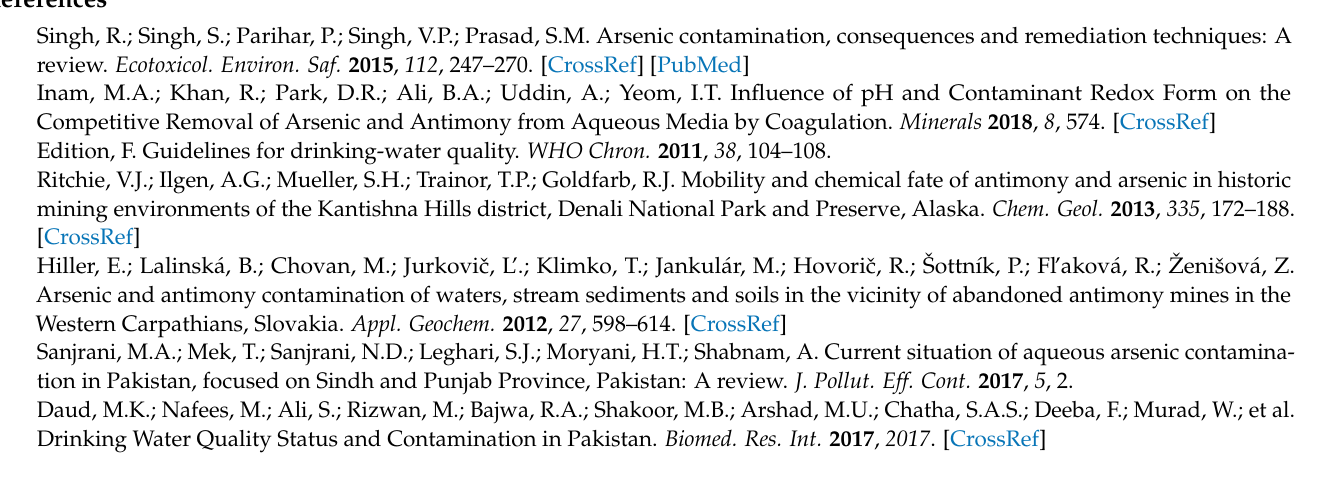
Figure S2: FHO formation in the presence of 1000 µ g/L (A) As (III) and (B) As (V) species, neutral pH, 0.1 m mol/L FC dosage and various temperature (15–35 ◦ C) and contact times (0–28 min), Figure S3: FHO formation in the presence of 100 µ g/L (A) As (III); and (B) As (V) species at optimum pH and temperature under various FC dosages in water, Figure S4: FHO formation in the presence of 500 µ g/L (A) As (III); and (B) As (V) species at optimum pH and temperature under various FC dosages in water, Figure S5: FHO formation in the presence of 1000 µ g/L (A) As (III); and (B) As (V) species at optimum pH and temperature under various FC dosages in